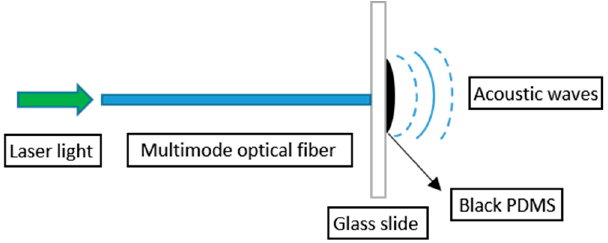
Figure 1. The structure of fiber optic ultrasonic generator.